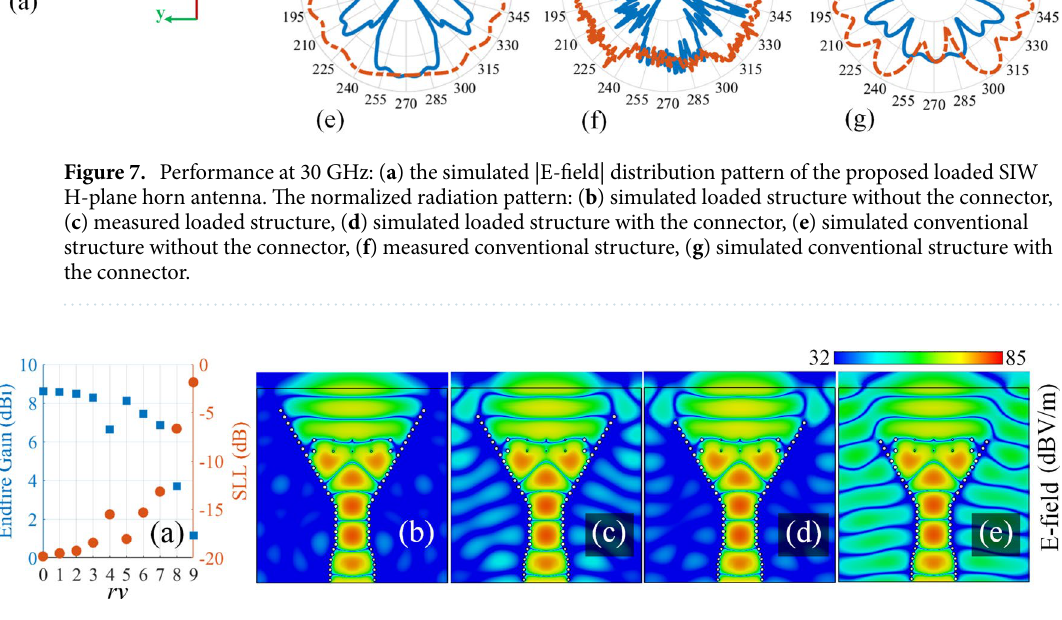
Figure 8. ( a ) The endfire gain and SLL for rv = 0 ∼ 9 . |E-field| distribution for ( b ) rv = 3 , ( c ) rv = 4 , ( d ) rv = 5 , and ( e ) rv = 8 at 30